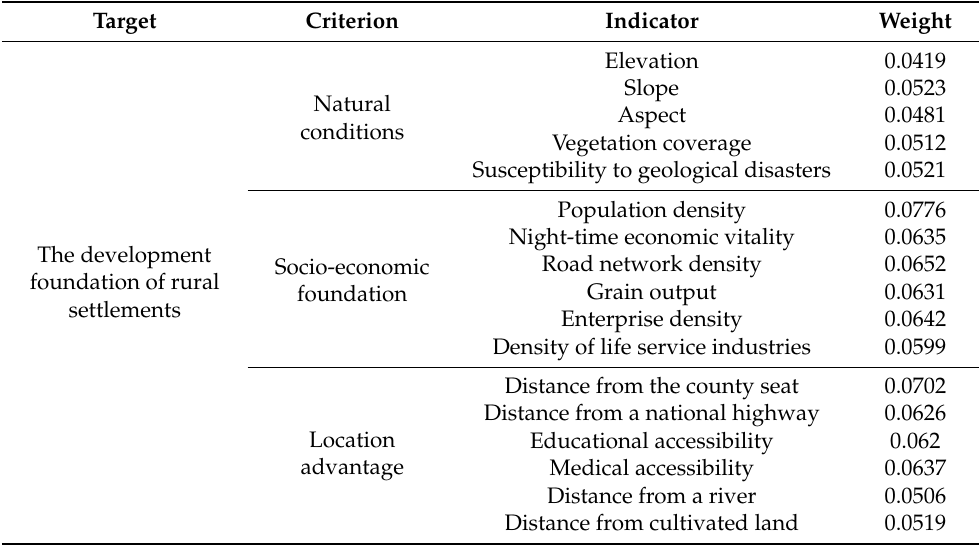
Table 1. Thecomprehensiveevaluationindicatorsystemforthedevelopmentfoundationofruralsettlements. Target